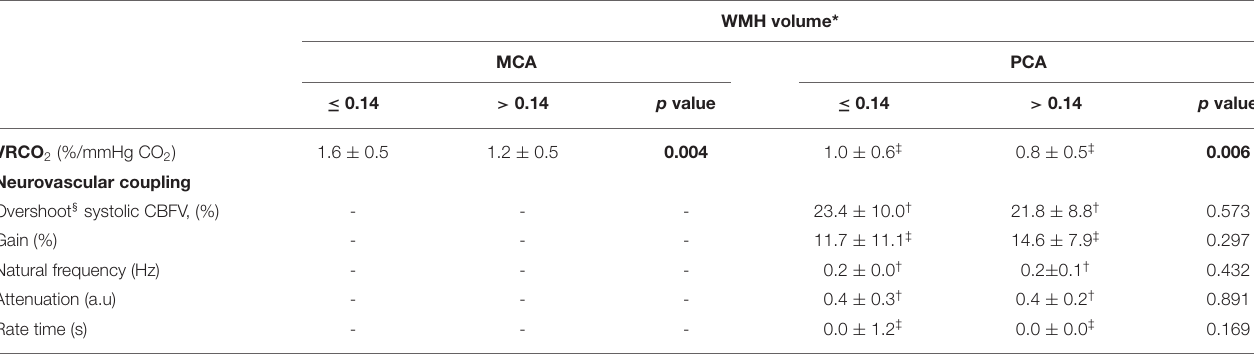
FIGURE 3 | Evoked systolic CBFV responses in the PCA and MCA during visual stimulation with the flickering checkerboard in one HT patient. The black lines represent the PCA response (thin lines: measured responses, thick lines: modeled blood flow data) and the gray lines represent the MCA measured response, used as a control. TABLE 4 | NVC and VRCO 2 in relation to the WMH volume in hypertensive